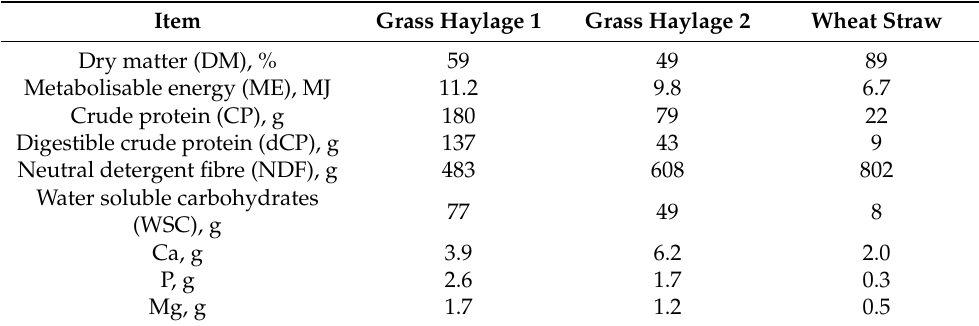
Table 1. Dry matter, energy and nutrient content per kg dry matter (DM) in the feeds used in the study. Item Grass Haylage 1